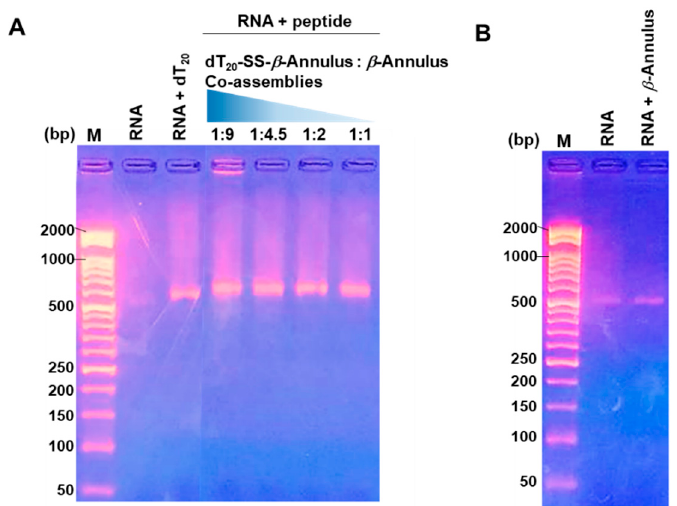
Figure 4. Gel shift assay of ( A ) co-assembly peptides hybridized with mCherry mRNA, ( B ) mixture of β -annulus peptide and mCherry mRNA in phosphate buffered saline (PBS) (pH 7.4) incubated at 25 °C for 30 min. M: DNA marker. All DNA markers used in the gel shift assay are the same. The gels were stained with GelRed.